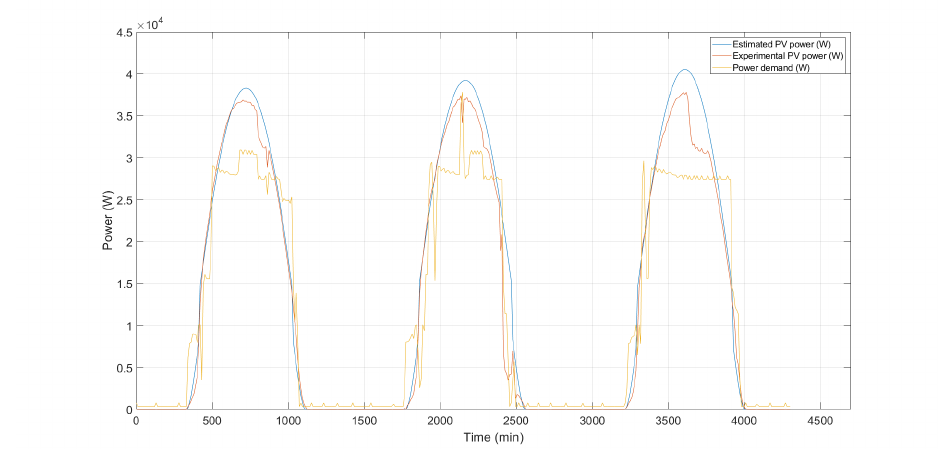
Figure 10. Simulation profiles. Prediction of photovoltaic (PV) power (blue), estimation of PV power with perturbation (orange), and original system power demand